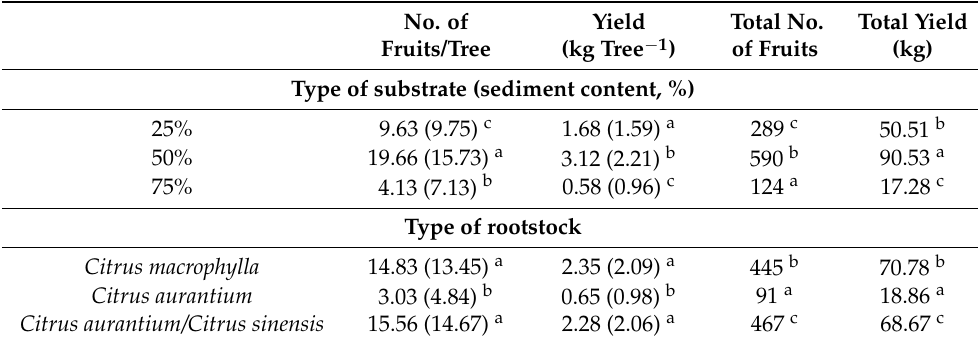
Table 2. Variation of the production of ‘Verna’ lemons obtained depending on the type of substrate and the rootstock used. The values per tree correspond to the mean with its standard deviation in parentheses. Total values are the sum of production per independent variable.